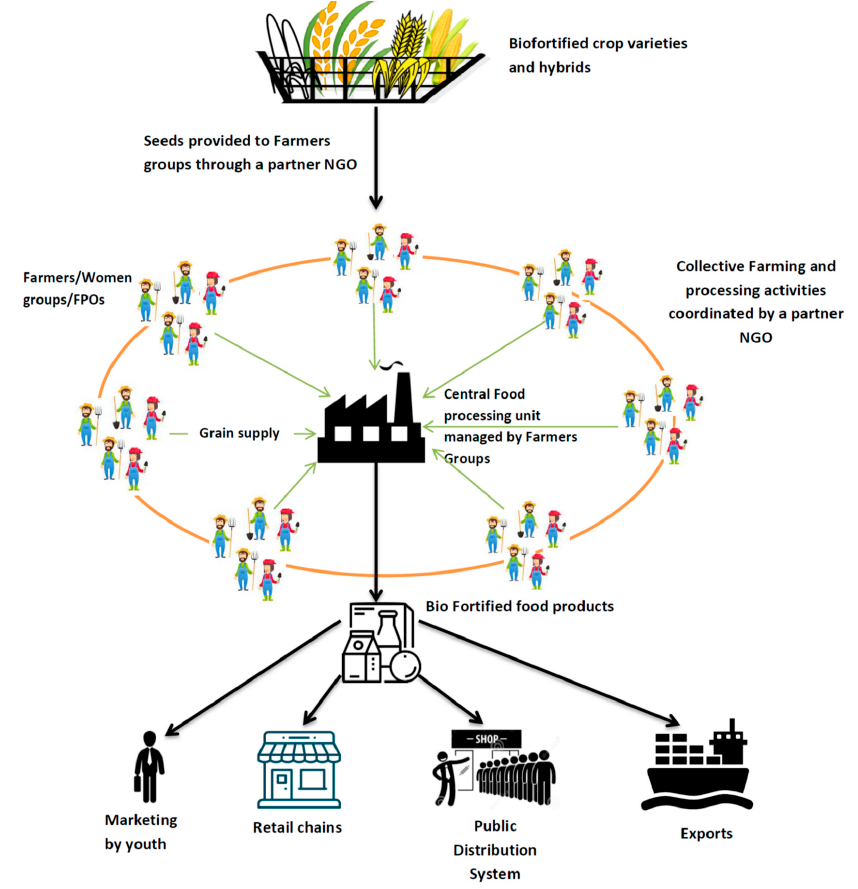
Figure 6. Proposed scaling up pathway for biofortified grains from the varieties and hybrid in India (from production to consumption).